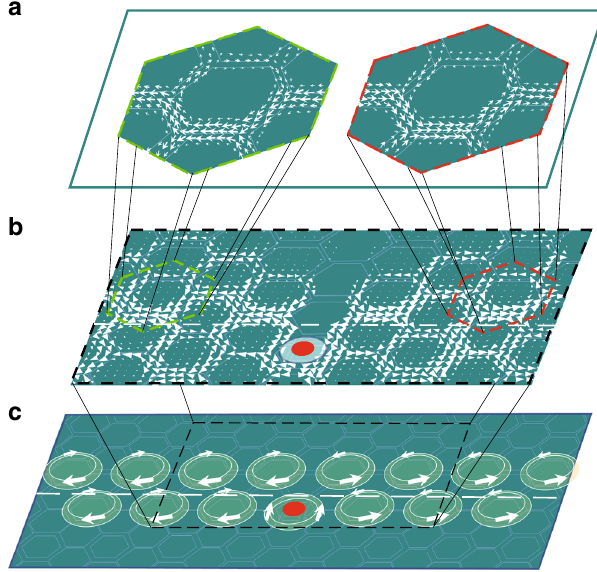
Fig. 4 Distributions of local Poynting vectors in the interface EM modes. a Distribution of the local Poynting vectors obtained by experimental measurements of the amplitude and phase of the out-of-plane electric fi eld E z (see Equation (4)) in the two hexagonal unit cells bounded by the dashed lines in ( b ) at 1.44 GHz. The size and direction of the arrows denote the amplitude and direction of the local Poynting vectors. b Distribution of the local Poynting vectors obtained by the full-wave simulations at 1.47 GHz in the region bounded by the dashed line in ( c ). c Schematic of the distribution of the local Poynting vector S over hexagonal unit cells in the topological interface modes stimulated by a linearly polarized source located in one of the unit cells (the red